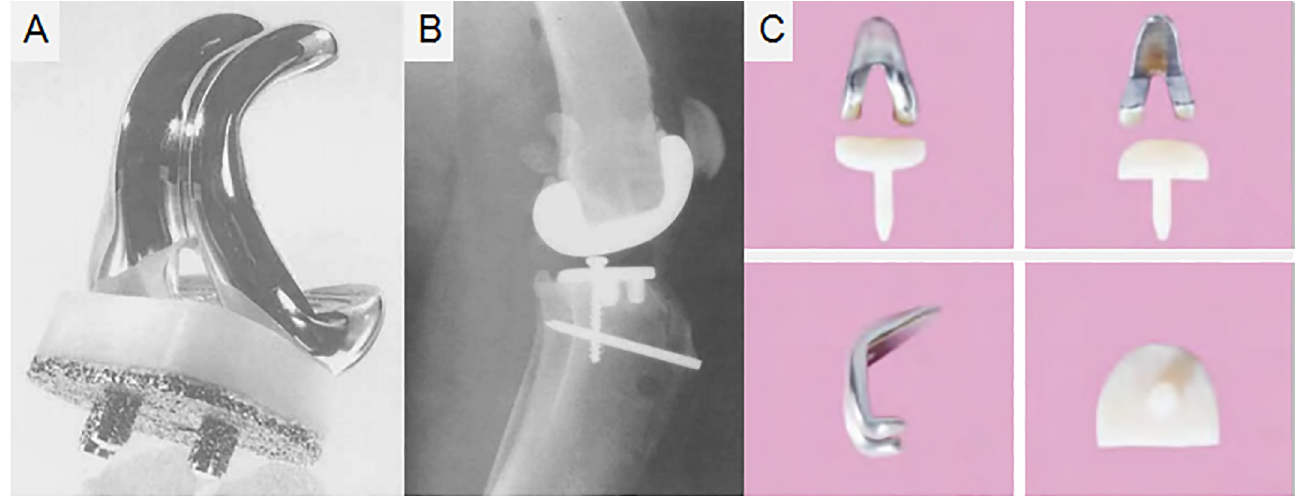
Fig 3. The appearance of two prostheses. (The figures were derived from references.) (A-B ) An unrestricted posterior CR prosthesis implanted in a dog model [19].( C) An anatomical joint prosthesis implanted in a rabbit model